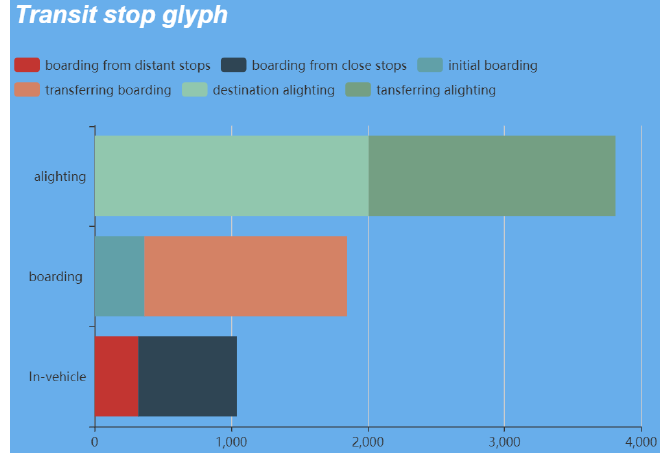
Figure 8. Transit stop glyph.